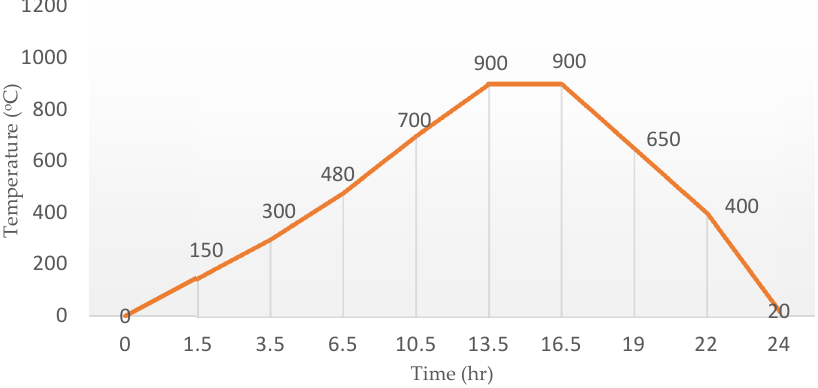
Figure 7. The firing circle followed for every tested mixture.